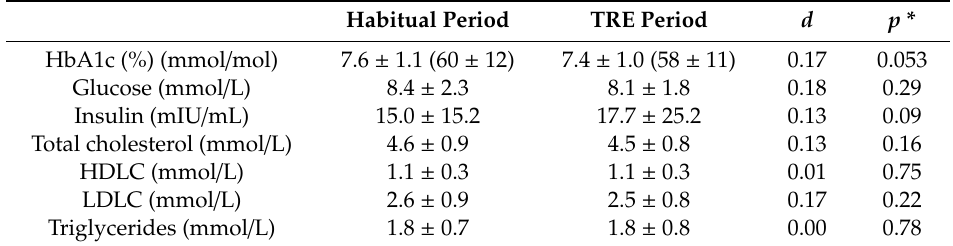
Table 5. Concentrations of blood metabolites measured after a > 10 h fast in individuals with type 2 diabetes and overweight / obesity measured at the end of the 2-week Habitual period and after the 4-week TRE intervention period.